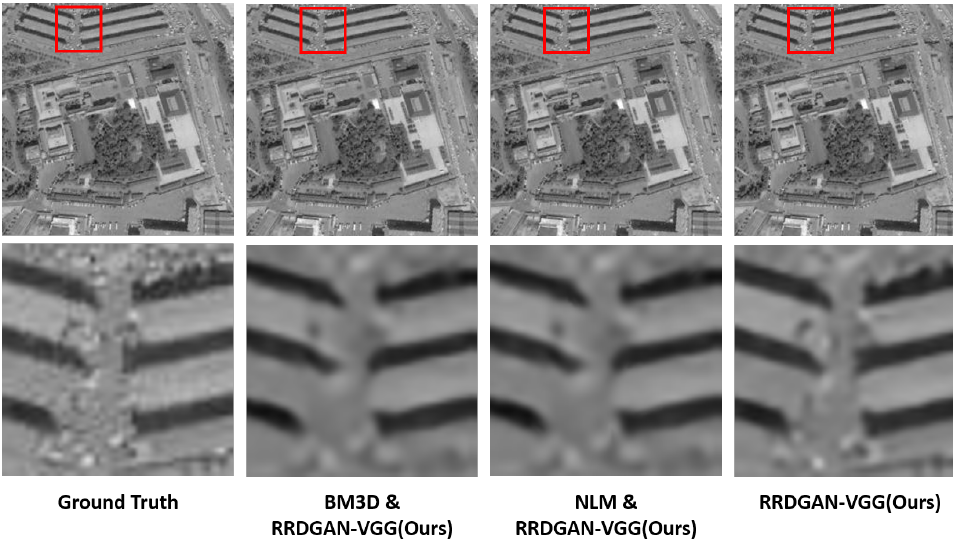
Figure 17. Comparison results of implementing BM3D (or NLM) and RRDGAN and implementing RRDGAN